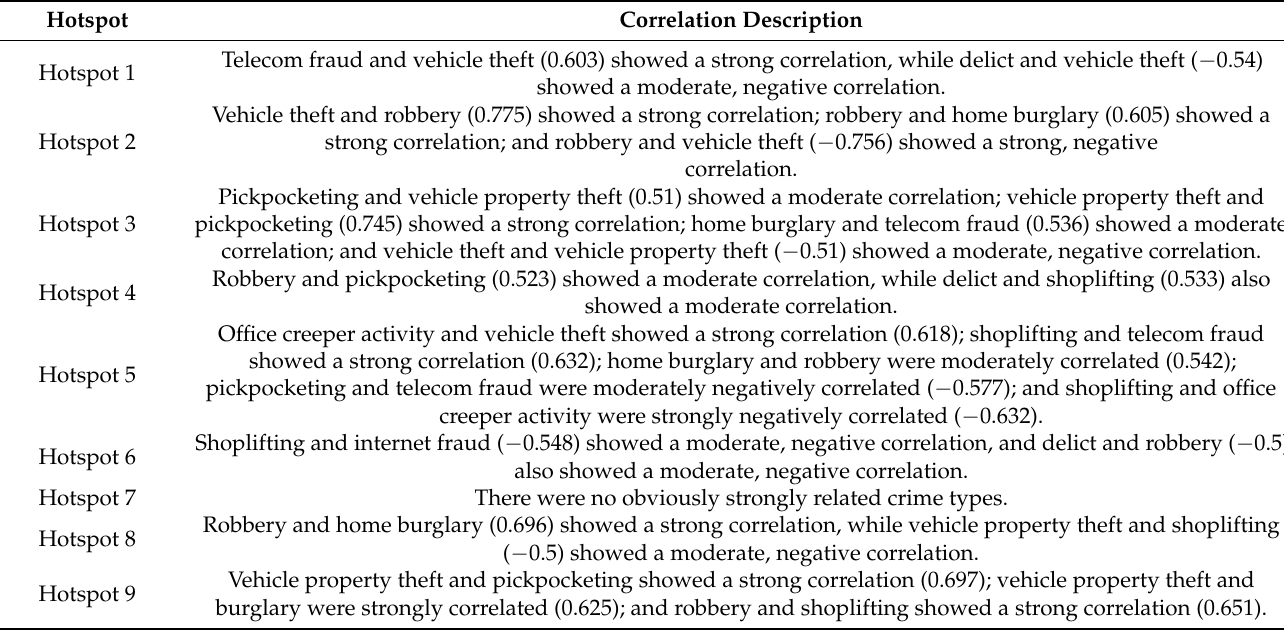
Figure 4. Strong correlation coe ffi cients of crime types. Table 4. Strong correlation coe ffi cients of crime types.